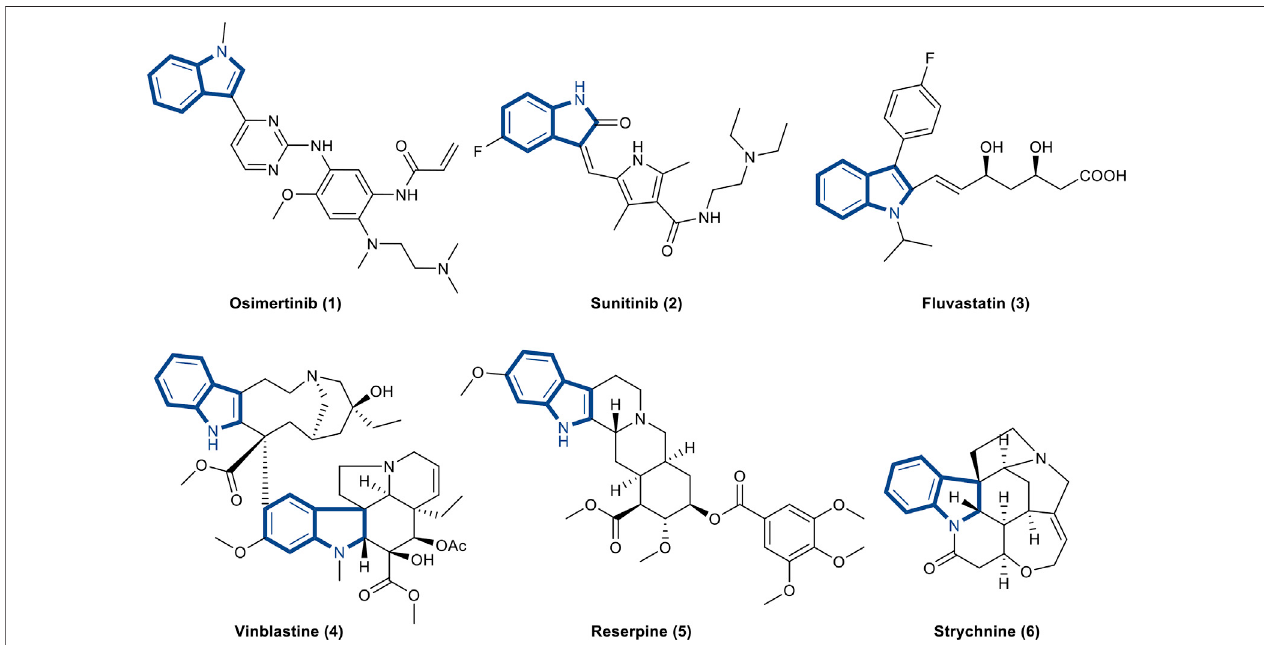
FIGURE1| Representativedrugscontainingindoleskeleton. (1) .Osimertinibisthe fi rstandonlyNSCLCdrugapprovedfortheEGFRT790Mmutation(Soriaetal., 2018). (2) . Sunitinib is a new multi-targeted tyrosine kinase inhibitor for the treatment of tumors (Beuselinck et al., 2015). (3) . Fluvastatin is a hydroxymethylglutaryl-CoA (HMG-CoA) reductase inhibitor and a fully synthetic blood lipid lowering drug (Henriksbo et al., 2014). (4) . Vinblastine is an antitumor drug extracted from Catharanthus roseus that interferes with protein synthesis (Sasaki et al., 2010). (5) . Reserpine is an antihypertensive drug found in the roots of Rauwol fi a serpentine (Abdelfatah and Efferth, 2015). (6) . Strychnine is an indole alkaloid extracted from Strychnos that excites the spinal cord and enhances skeletal muscle tone Mori et al., 2003.